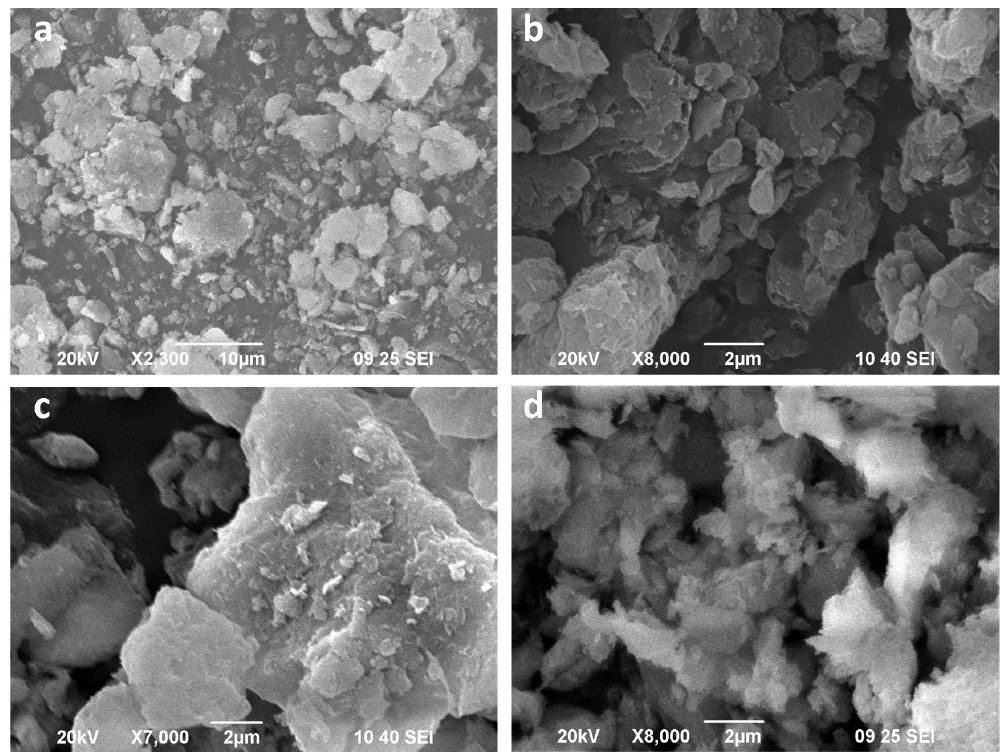
Figure 4. SEM micrographs of natural Sm ( a ), Sm–H ( b ), Fe–Sm ( c ), and Fe–Sm–H ( d ).